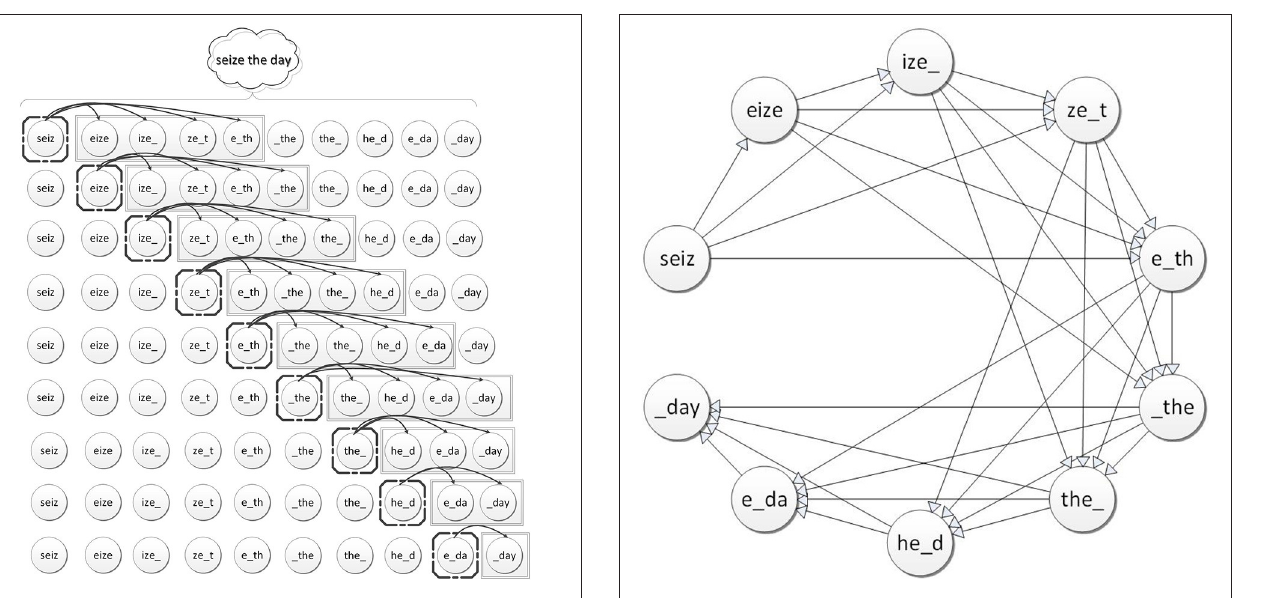
FIGURE 3 | Edge construction sliding a window of rank 4. FIGURE 4 | 4-Gram graph representation of the sentence “seize the